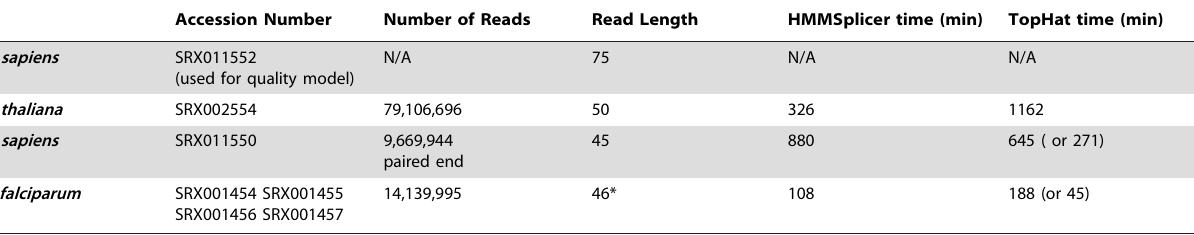
Table 3. Datasets.